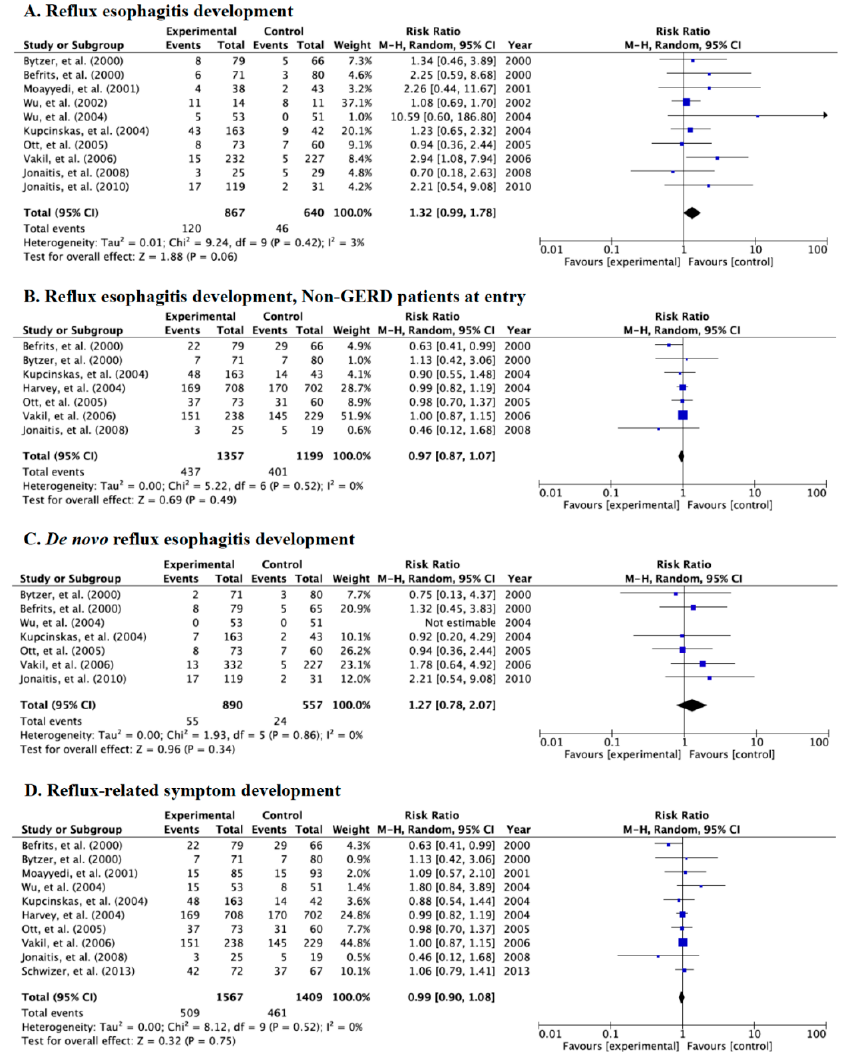
Figure 3. Forest plots of the rate of patients with reflux esophagitis development after eradication irrespective of whether they were free from gastroesophageal reflux disease (GERD) at baseline ( A ), reflux esophagitis after eradication in patients that were free from GERD at baseline ( B ), the rate of de novo reflux esophagitis newly developed after eradication ( C ), and the rate of patients with reflux-related symptoms after eradication therapy ( D ) in the random-effects model in Category A. No significant difference in reflux esophagitis and symptoms was shown between the case and control groups. Abbreviations: CI, confidence interval.